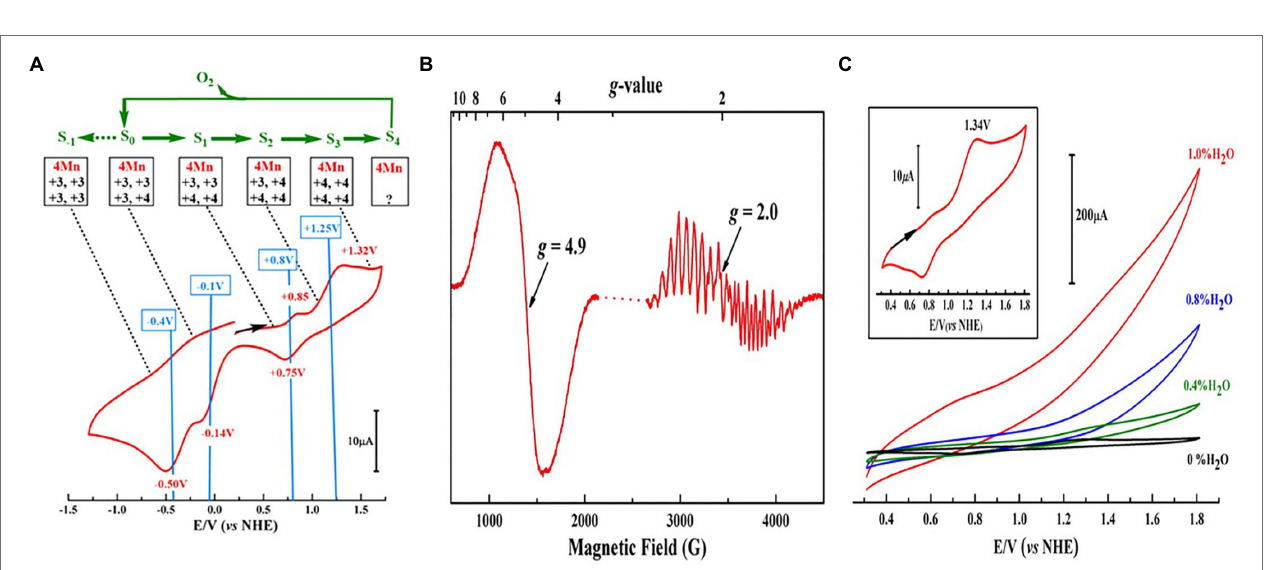
FIGURE 5 | Structural comparison of the OEC (Suga et al., 2015) and the artificial Mn 4 CaO 4 -complex ( 4 ) (Zhang et al., 2015). (A) Core of the OEC; (B) structure of the OEC; (C) core of 4 ; (D) structure of 4 . The data for the OEC is taken from the first monomer in the crystal structure data of PSII with the Protein Data Bank code 4UB6. For clarity, the methyl groups and the hydrogen atoms are not shown. All other illustrations are the same as those in Figure 4 .